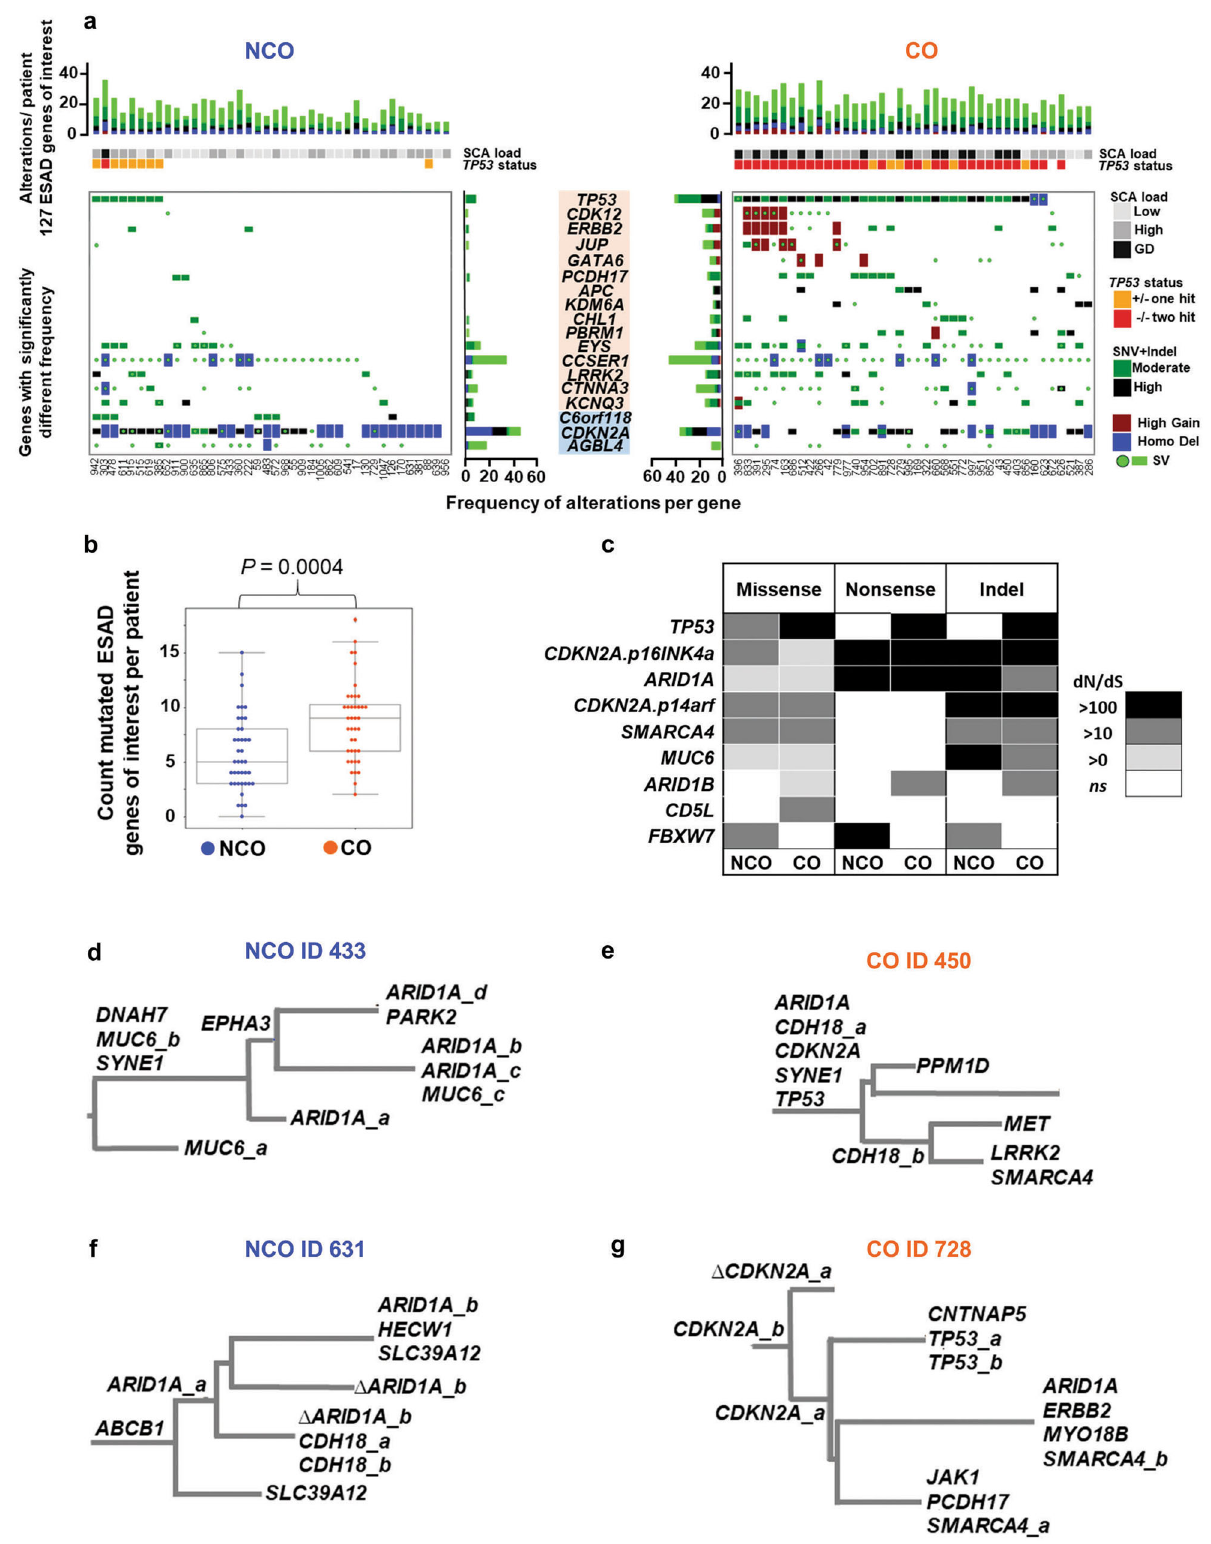
revealed if causal mutations occur only at low frequency in any one gene, but rather are spread across many genes in a pathway or a process 15 . We conducted a comprehensive gene pathway analysis to evaluate the effects of the individual mutations (SNVs/ indels and double deletions) on pathway function (Supplemen- tary Data Files 16, 17, and 18); copy number and SV